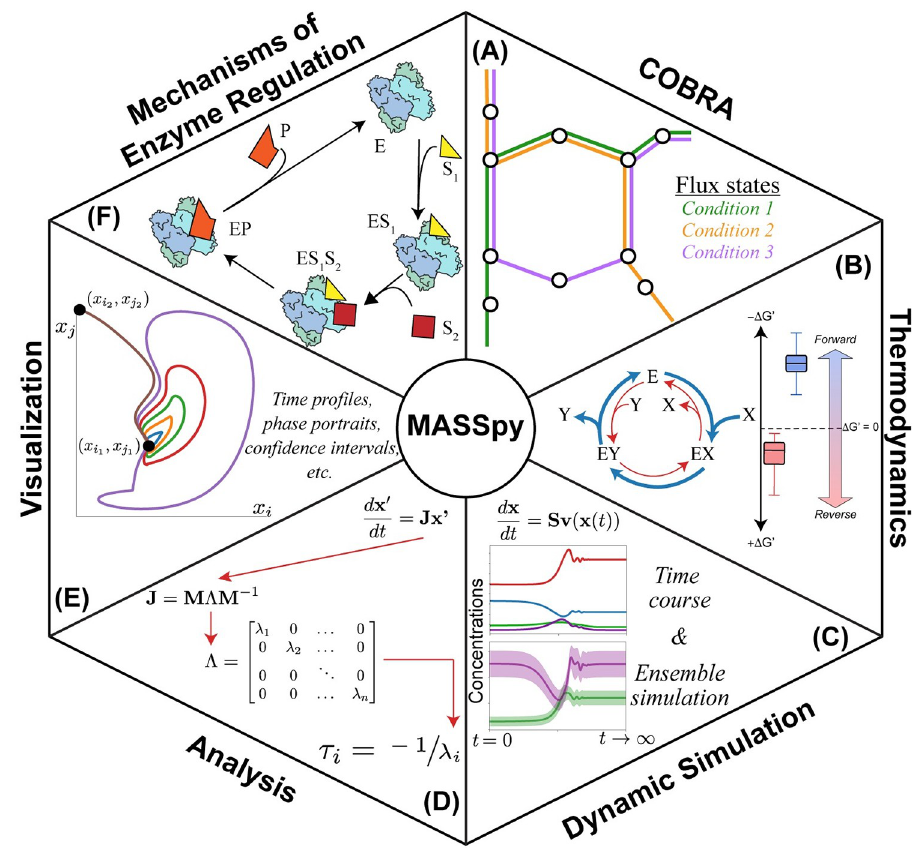
Fig 1. Overview of MASSpy features. (A) MASSpy expands COBRApy to provide constraint-based methods for obtaining flux states. (B) Thermodynamic principles are utilized by MASSpy to sample concentration solution spaces and to evaluate how thermodynamic driving forces shift under different metabolic conditions. (C) MASSpy enables dynamic simulation of models to characterize transient dynamic behavior and contains ensemble modeling methods to represent biological uncertainty. (D) Network properties such as relevant timescales and system stability are characterized by MASSpy using various linear algebra and analytical methods. (E) MASSpy contains built-in functions that enable the visualization of dynamic simulation results. (F) Mechanisms of enzymatic regulation are explicitly modeled in MASSpy through enzyme modules, enabling computation of catalytic activities and functional states of